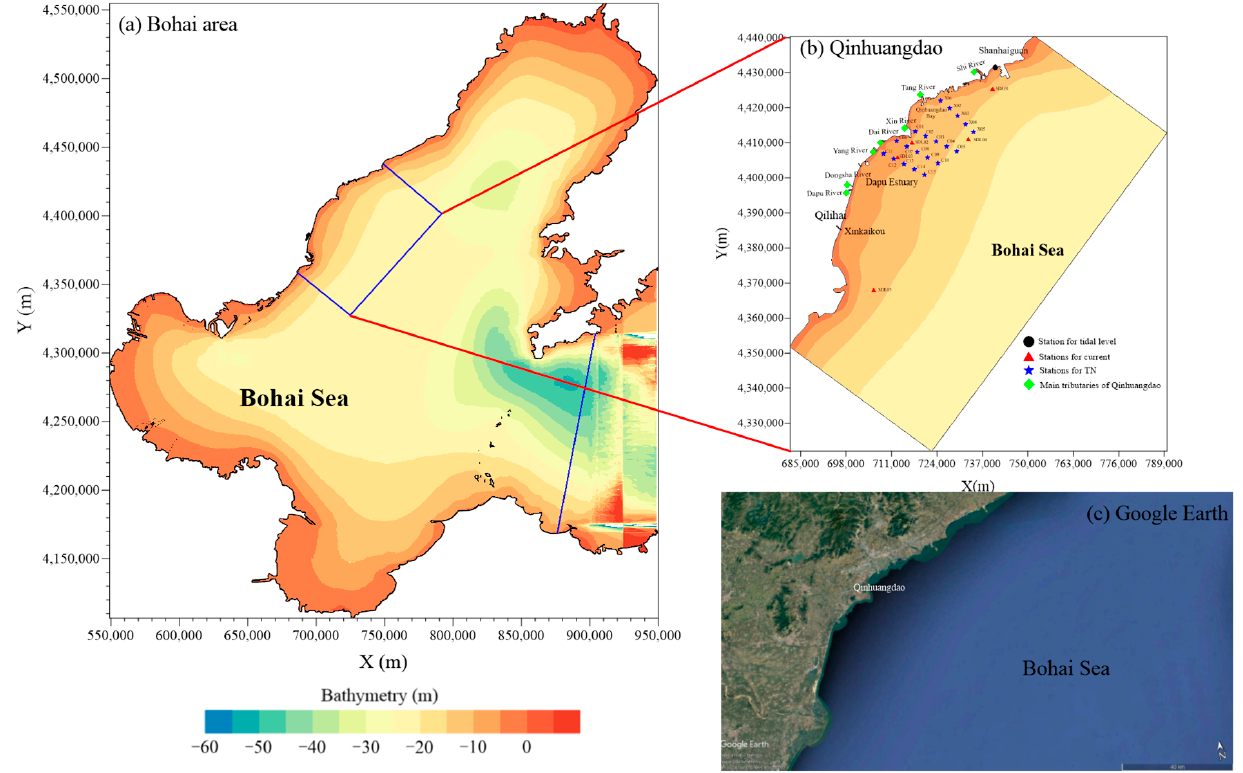
Figure 1. ( a ) The Bohai Sea area; ( b ) the main study area and the field observation stations (the black circle represents the tidal level station, the red triangles are the current stations, and the blue pentagrams show the position of TN stations). ( c ) Google Earth view of Qinghuangdao and the Bohai Sea.